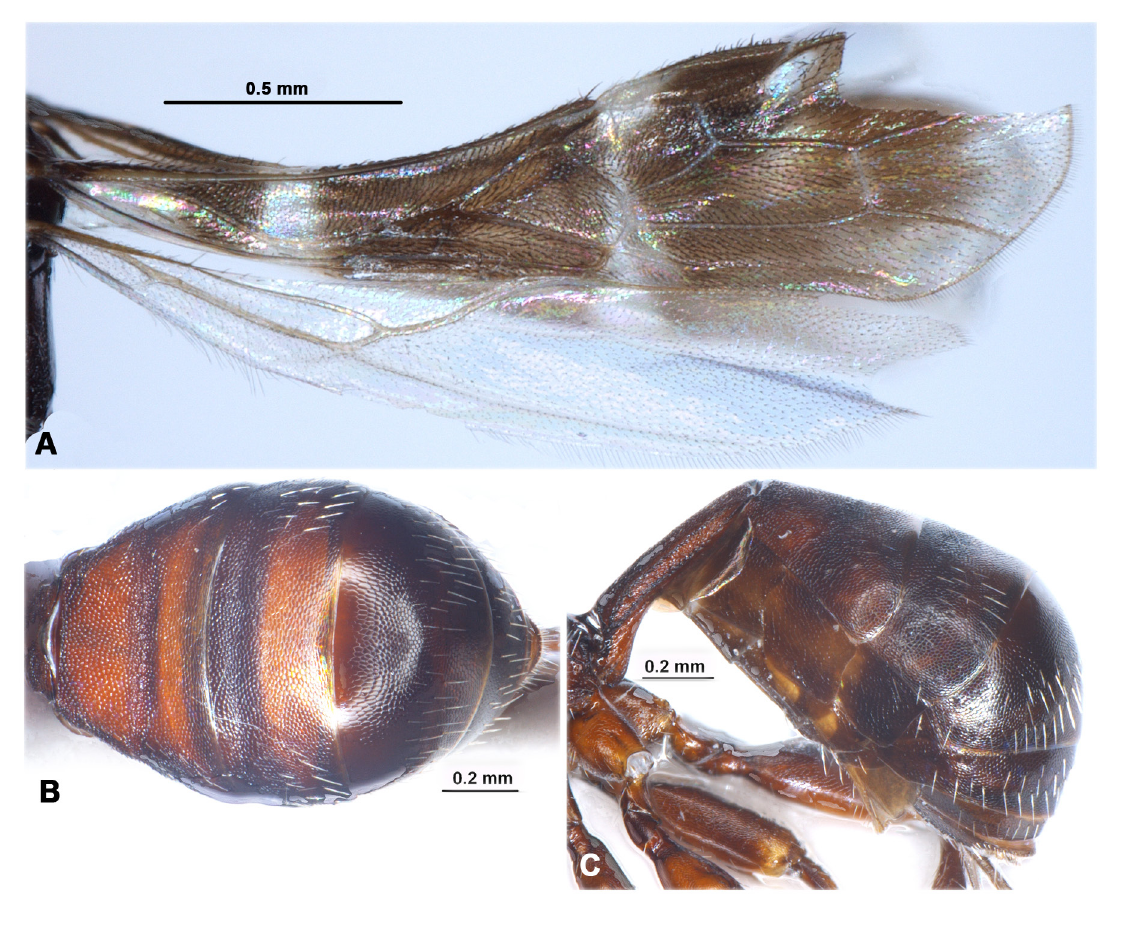
Fig. 40. Platyspathius ( P. ) brevis Belokobylskij sp. nov., holotype, ♀ (RMNH). A . Wings. B . Metasoma without first tergite, dorsal view. C . Metasoma, lateral